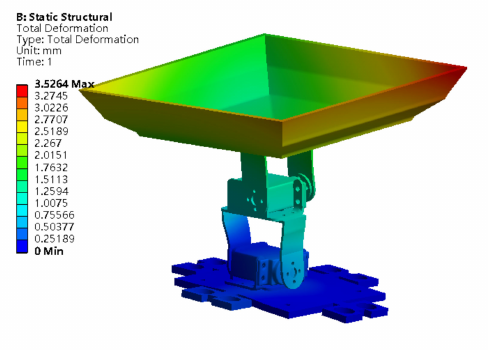
Figure 11. Displacement map of the platform.